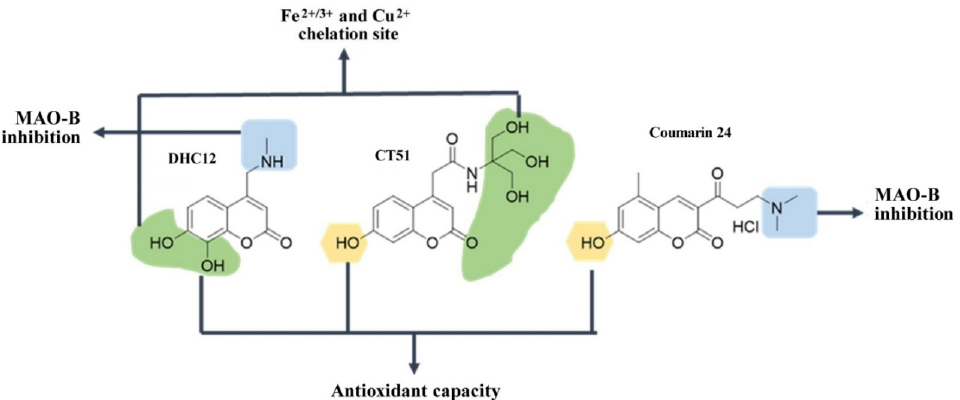
Figure 4. Structure of coumarins with neuroprotective activity. Green shadowing shows iron chelation sites; yellow shadowing shows free radical scavenger sites; blue shadowing shows MAO-B inhibition sites.